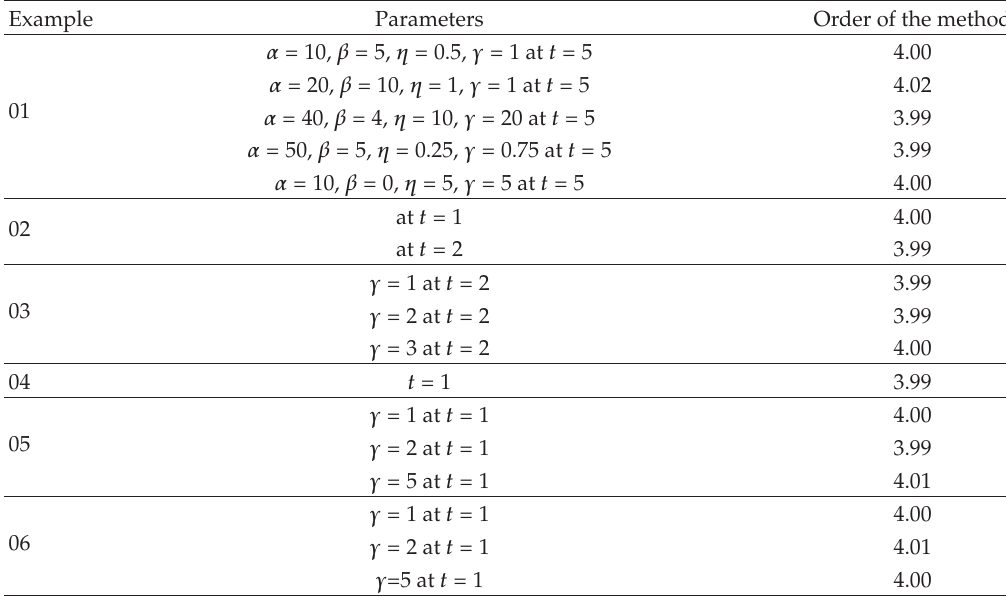
Table 7: Order of